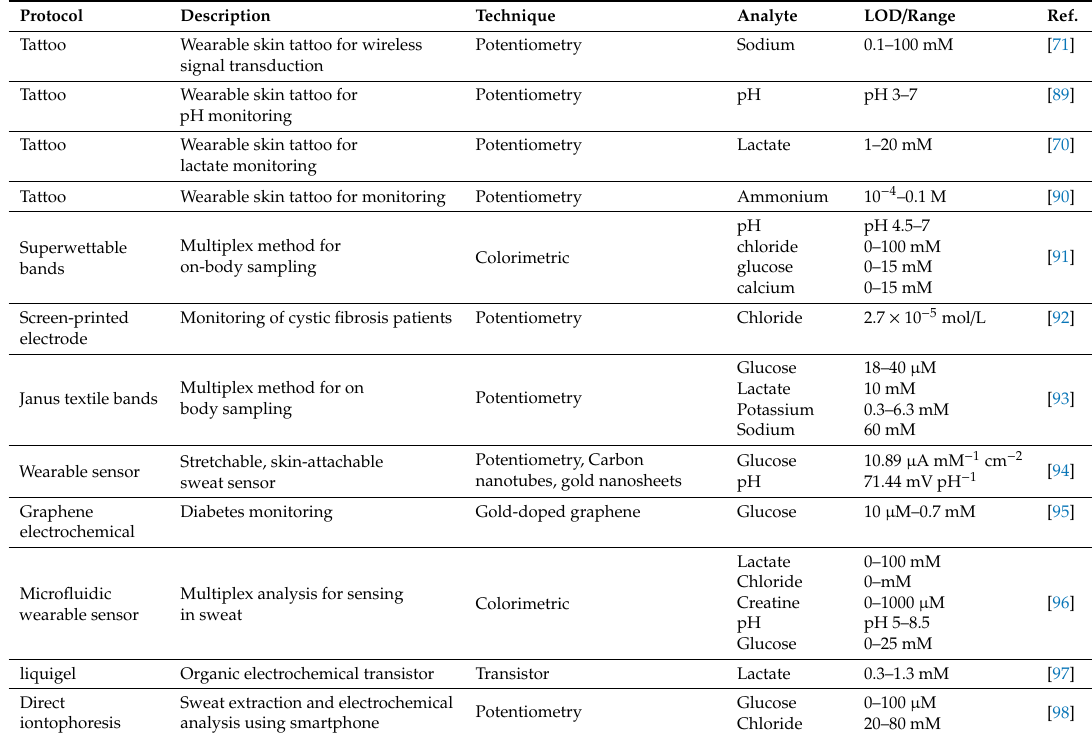
Table 1. Recent biosensor analysis techniques for